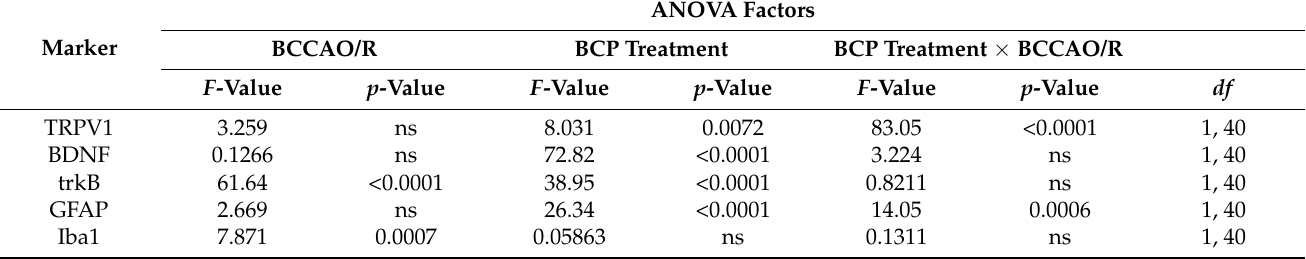
Table 1. F -values and significance levels from two-way ANOVA performed on mean values of marker protein levels obtained after transient bilateral common carotid artery occlusion followed by reperfusion (BCCAO/R) and beta-caryophyllene (BCP) pre-treatment by means of Western blot in the rat frontal cortex.